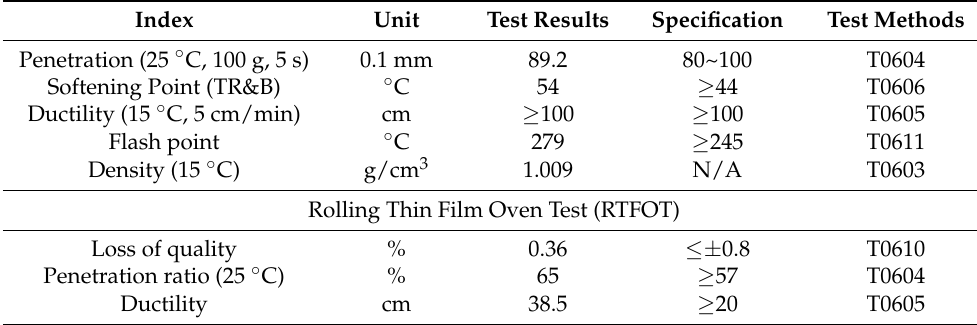
Table 1. Properties of the asphalt binder.